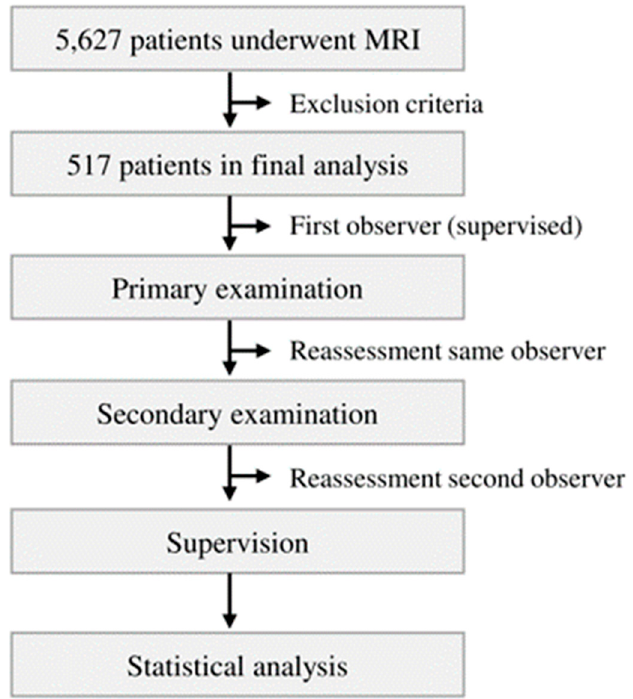
Figure 1. Flowchart about the experimental process of the presented study. After applying the described exclusion criteria, 517 MRIs were integrated into the final examination. Statistical analysis was performed after supervision process of examination.